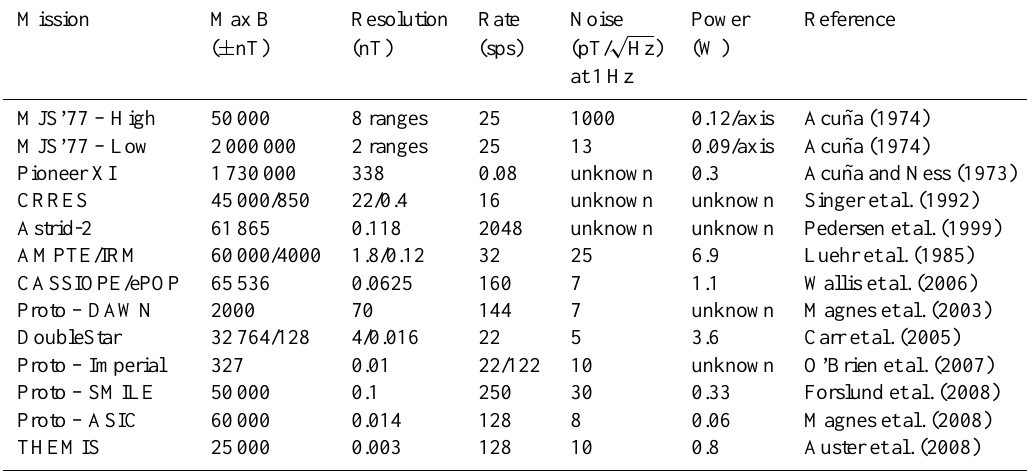
Table 1. Performance characteristics of relevant recent and historical spaceflight fluxgate magnetometers.